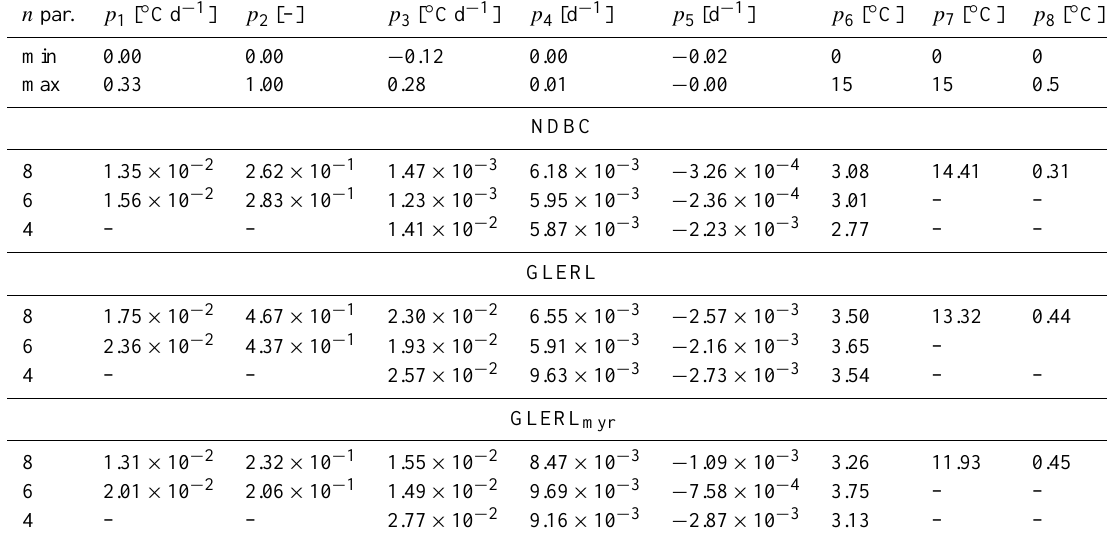
Table 2. Estimated model parameters for NDBC, GLERL and GLERL myr (mean year) simulations, and their estimated physical range of variation.